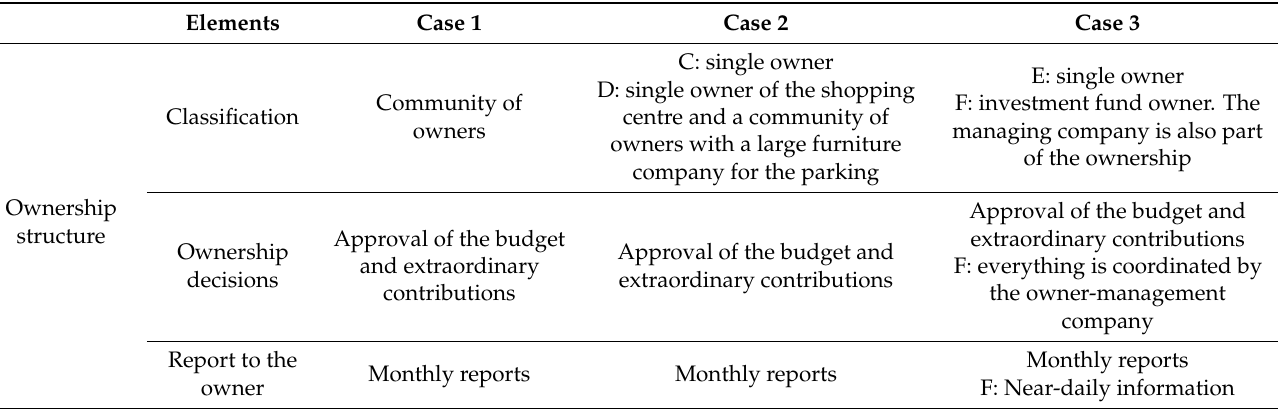
Table 3. Ownership structure 1